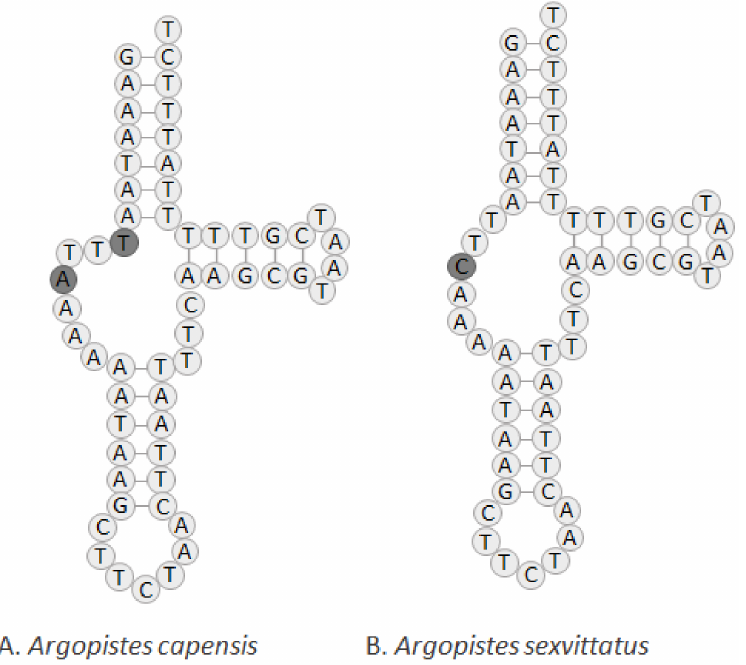
Figure 5. Predicted structure of tRNA Ser1(TCT) in the complete mitochondrial genomes of ( A ) A. capensis and ( B ) A. sexvittatus (striped and black